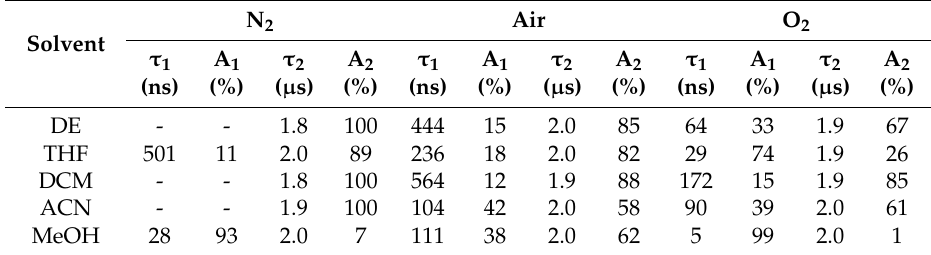
Table 4. Time constants ( τ i ), pre-exponential factors (A i ) extracted from the transient absorption decays fits of Me 2 CANADC in ACN, DCM, DE, MeOH, and THF observed at 500–525 nm upon excitation at 420 nm. The estimated error is around